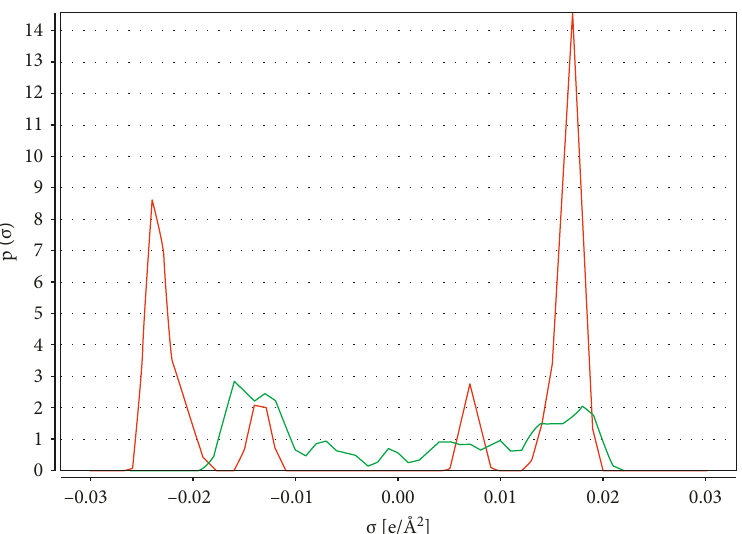
Figure 2: The sigma profile and sigma potentials of the NaCl–H